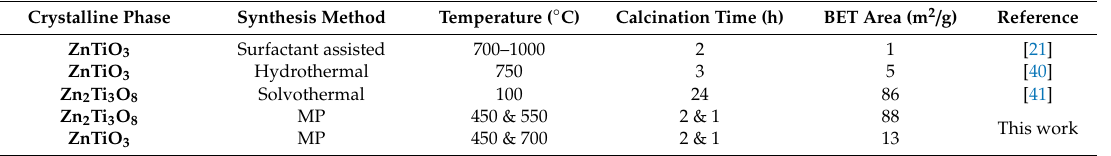
Table 2. Specific surface area comparison between cds-ZTO and p-ZnTiO 3 with respect to other zinc titanates obtained by different calcination temperatures and synthesis methods.